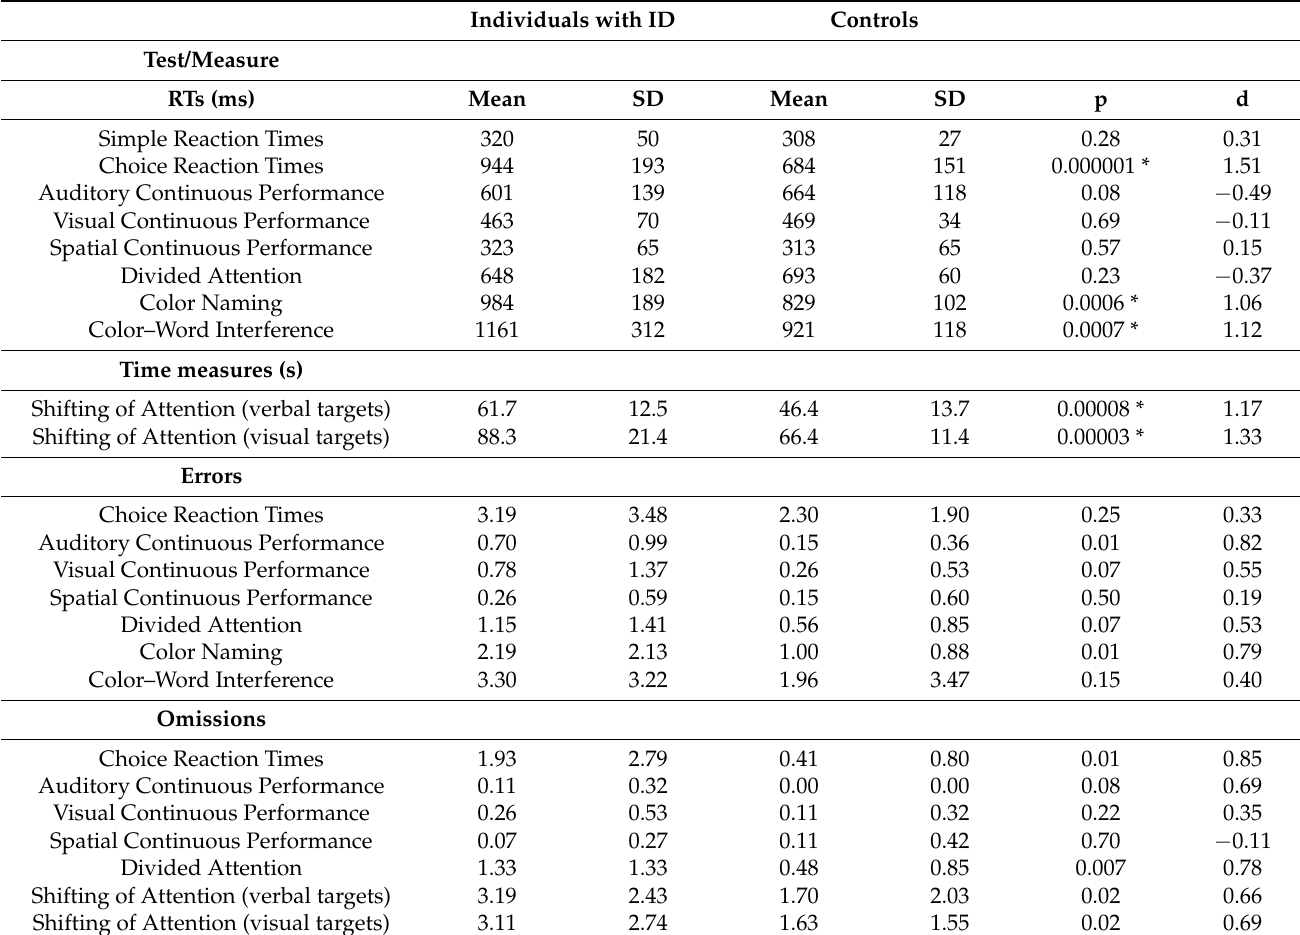
Table 2. Mean performance (and SD) in the Attention and Concentration Battery [54] of individuals with ID and controls. Reaction times (RTs) (in milliseconds (ms)), times (in seconds (s)), and percentages of errors and omissions are presented separately.The p -values associated with Scheme 0 are considered significant and are marked with an asterisk (*). Effect sizes (Cohen’s d values) are also reported.